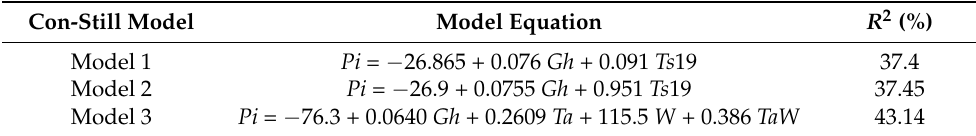
Table 4. Three generated models for con-still.